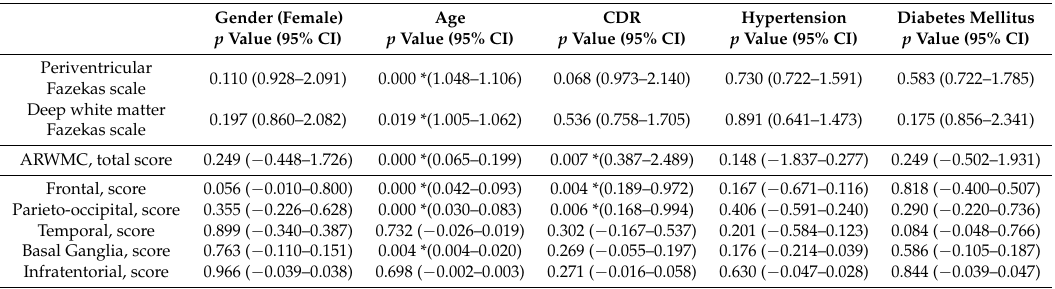
Table 5. Adjusted factors related to white matter changes in Alzheimer’s disease